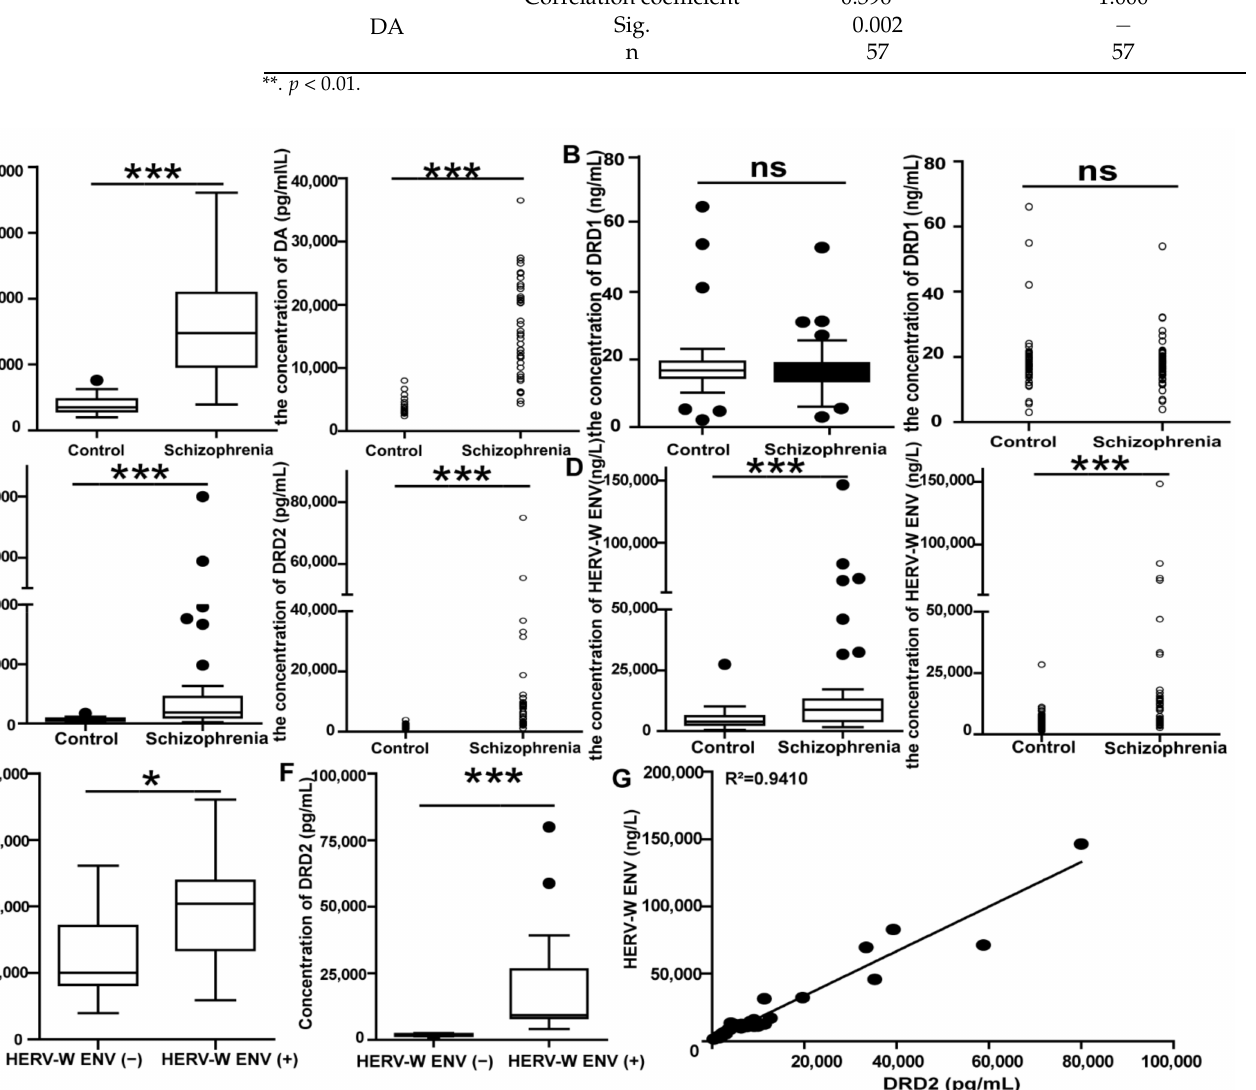
Figure 2. The correlation and consistency between DRD2 and HERV-W ENV in schizophrenia patients: ( A – D ) The concentration of DA, DRD1, DRD2, and HERV-W ENV in the control groups ( n = 68) and the schizophrenia patients ( n = 57). ( E , F ) The concentration of DA and DRD2 in the HERV-W ENV- negative schizophrenia (HERV-W ENV ( − ), n = 25) and the HERV-W ENV-positive schizophrenia (HERV-W ENV (+), n = 32) groups. ( G ) Correlation between HERV-W ENV antigenemia and DRD2 levels in schizophrenia patients. X -axis: DRD2 value for each schizophrenia patient. Y -axis: the concentration for the HERV-W ENV antigen with the HERV-W ENV antibody, obtained by enzyme immunosorbent assay (ELISA). The line represents the calculated “best-fit” equation of the values within the boxed area, with the correlation value indicated on the top (R 2 ). ns p > 0.05, * p < 0.05, *** p <